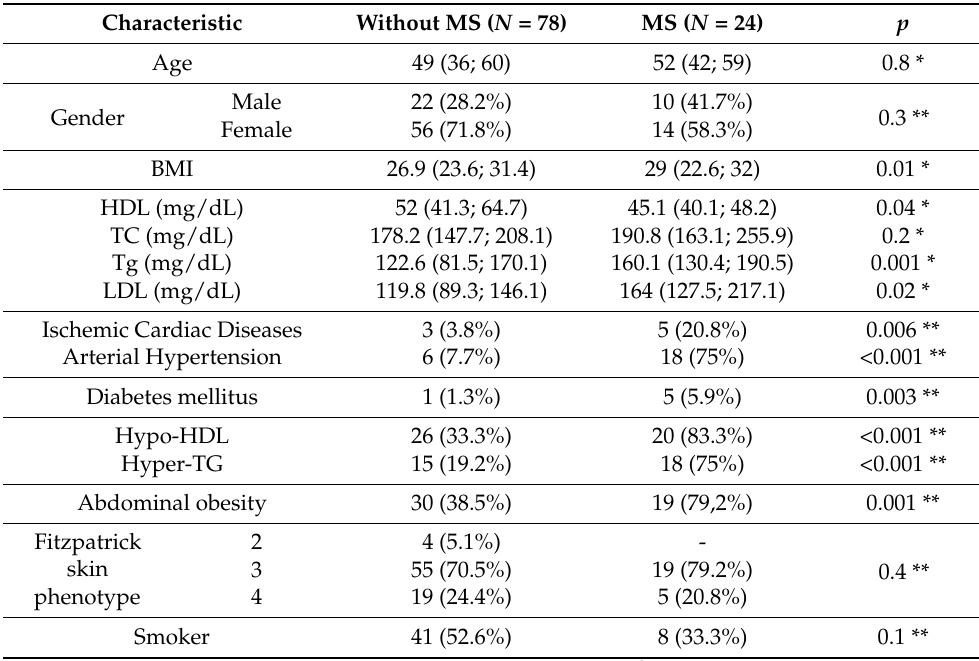
Table 1. Demographic, anthropometric, and health status characterization of the included patients with and without